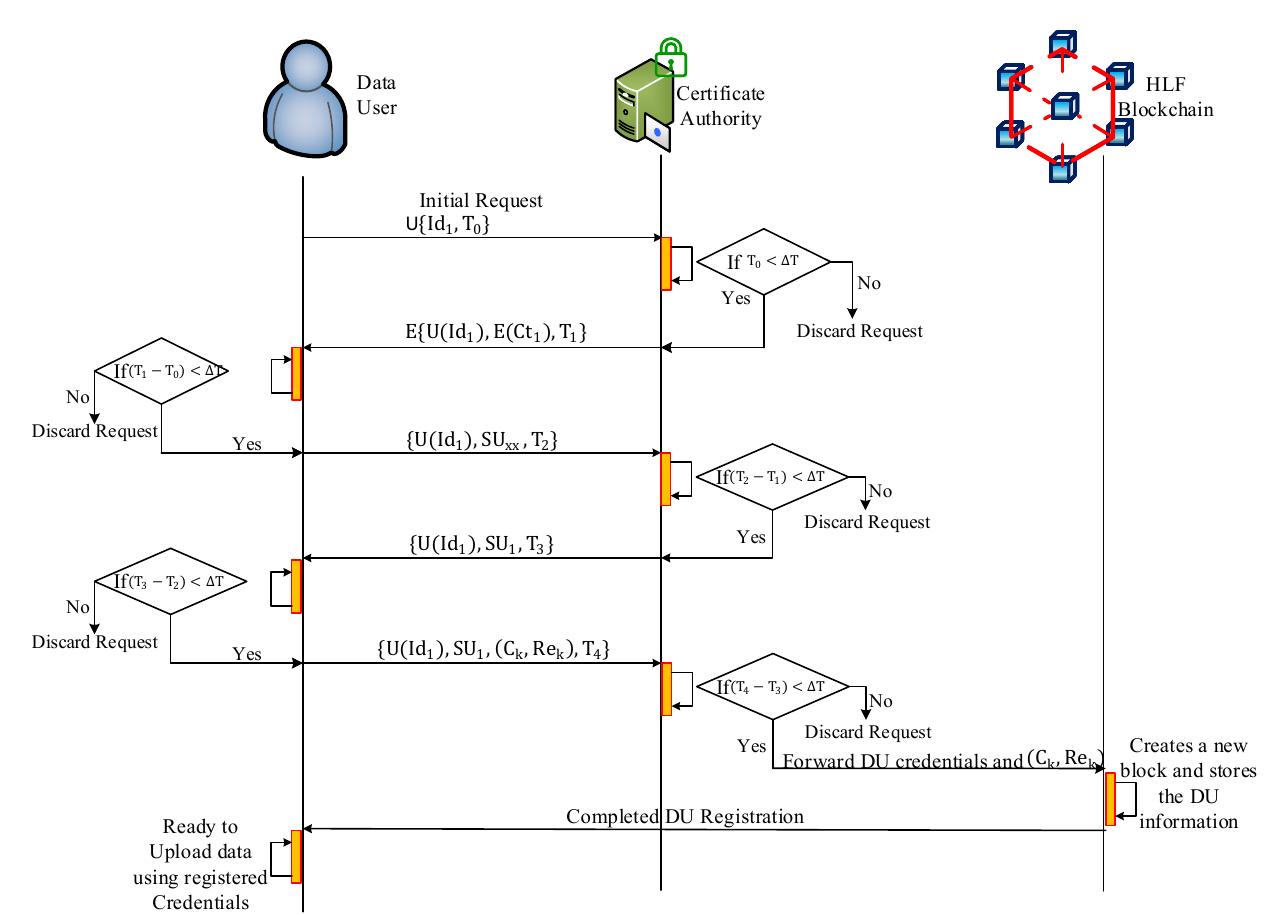
Figure 4. Workflow of the DU